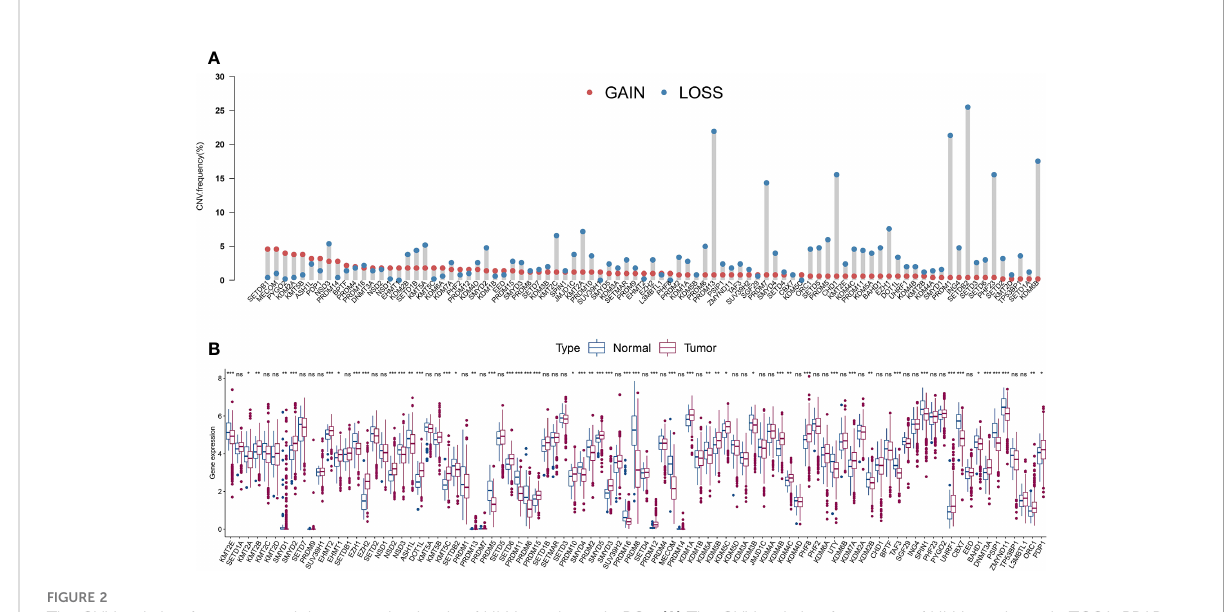
FIGURE 2 The CNV variation frequency and the expression levels of HLM regulators in PCa. (A) The CNV variation frequency of HLM regulators in TCGA-PRAD. Red dot, ampli fi cation frequency; Blue dot, deletion frequency. (B) The expression levels of the 91 HLM regulators in PCa and normal prostate tissues are shown as boxplot. The values of median ± interquartile ranges are shown in the graph. ns P > 0.05; *P < 0.05; **P < 0.01; ***P < 0.001.